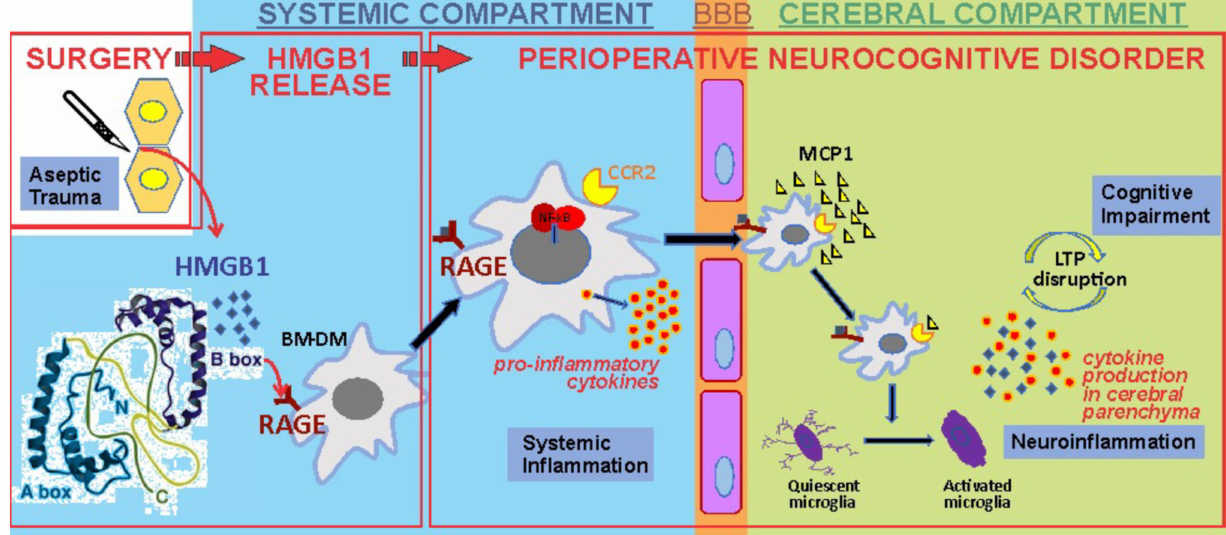
Figure 3. Peripheral trauma released HMGB1, which in turn engages the innate immune response by binding to receptors, including the receptor for advanced glycation end-products (RAGE), on circulating bone marrow-derived monocytes (BM-DM). This results in the translocation of the transcription factor nuclear factor kB (NF-kB) which increases the synthesis and release into the circulation of proinflammatory cytokines. These cytokines disrupt the blood–brain barrier (BBB), allowing the translocation of BM-DM into brain attracted by the chemokine monocyte chemoattractant protein-1 (MCP-1), which itself is HMGB1-dependent. In the presence of BM-DMs within the hippocampus, quiescent microglia become activated and release proinflammatory cytokines. Long-term potentiation (LTP), a synaptic plasticity mechanism required for creating and storing memory, is disrupted by the proinflammatory cytokines in the